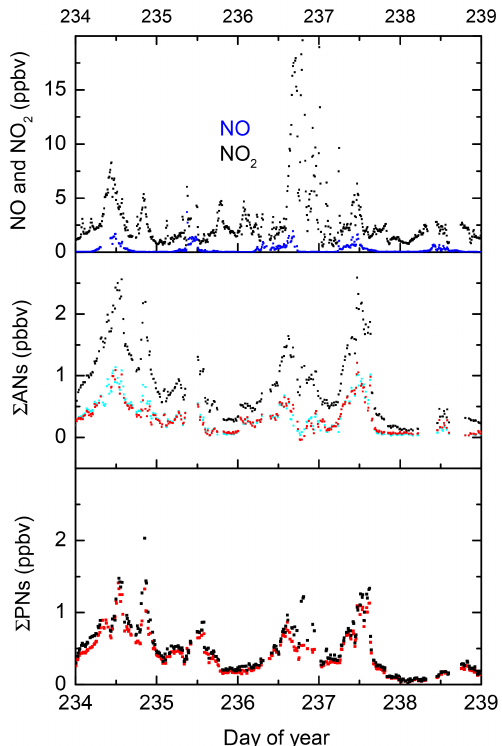
Figure 18. Time series of PARADE data over a 5 day period. Upper panel: NO 2 mixing ratios (black data points) measured in the refer- ence cavity along with NO measured by the CLD (blue data points). Central panel: TD cavity measurements when sampling from the 723K inlet. Black data points indicate uncorrected (raw) data. The blue data points were obtained by directly subtracting the NO 2 mix- ing ratios measured when sampling from the 473K inlet from that when sampling from the 723K inlet. The red data points include the corrections described in the text. Lower panel: uncorrected (black) and corrected (red) measurements of the (cid:54)